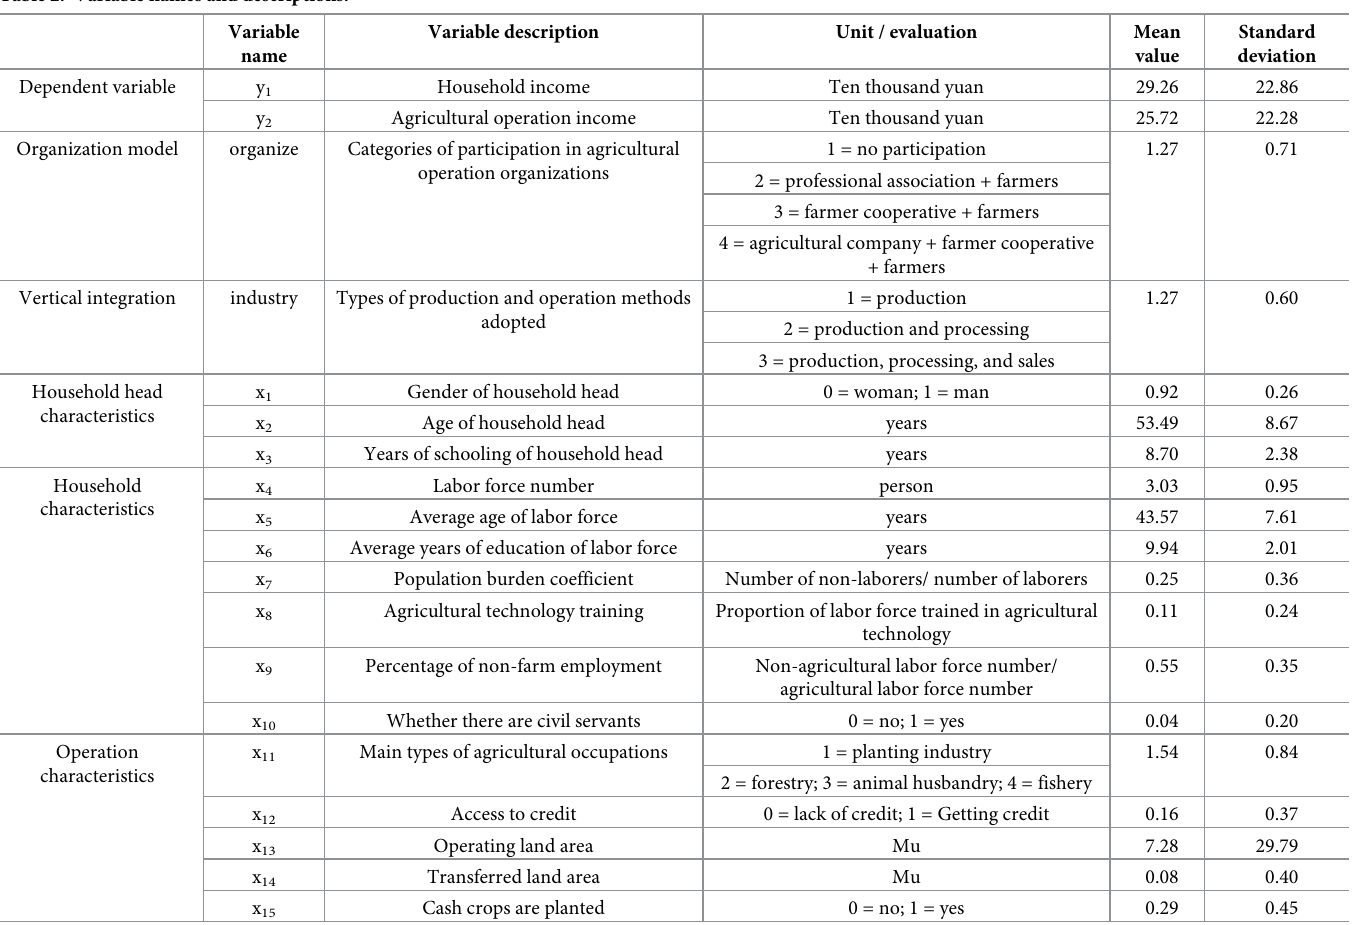
Table 2. Variable names and